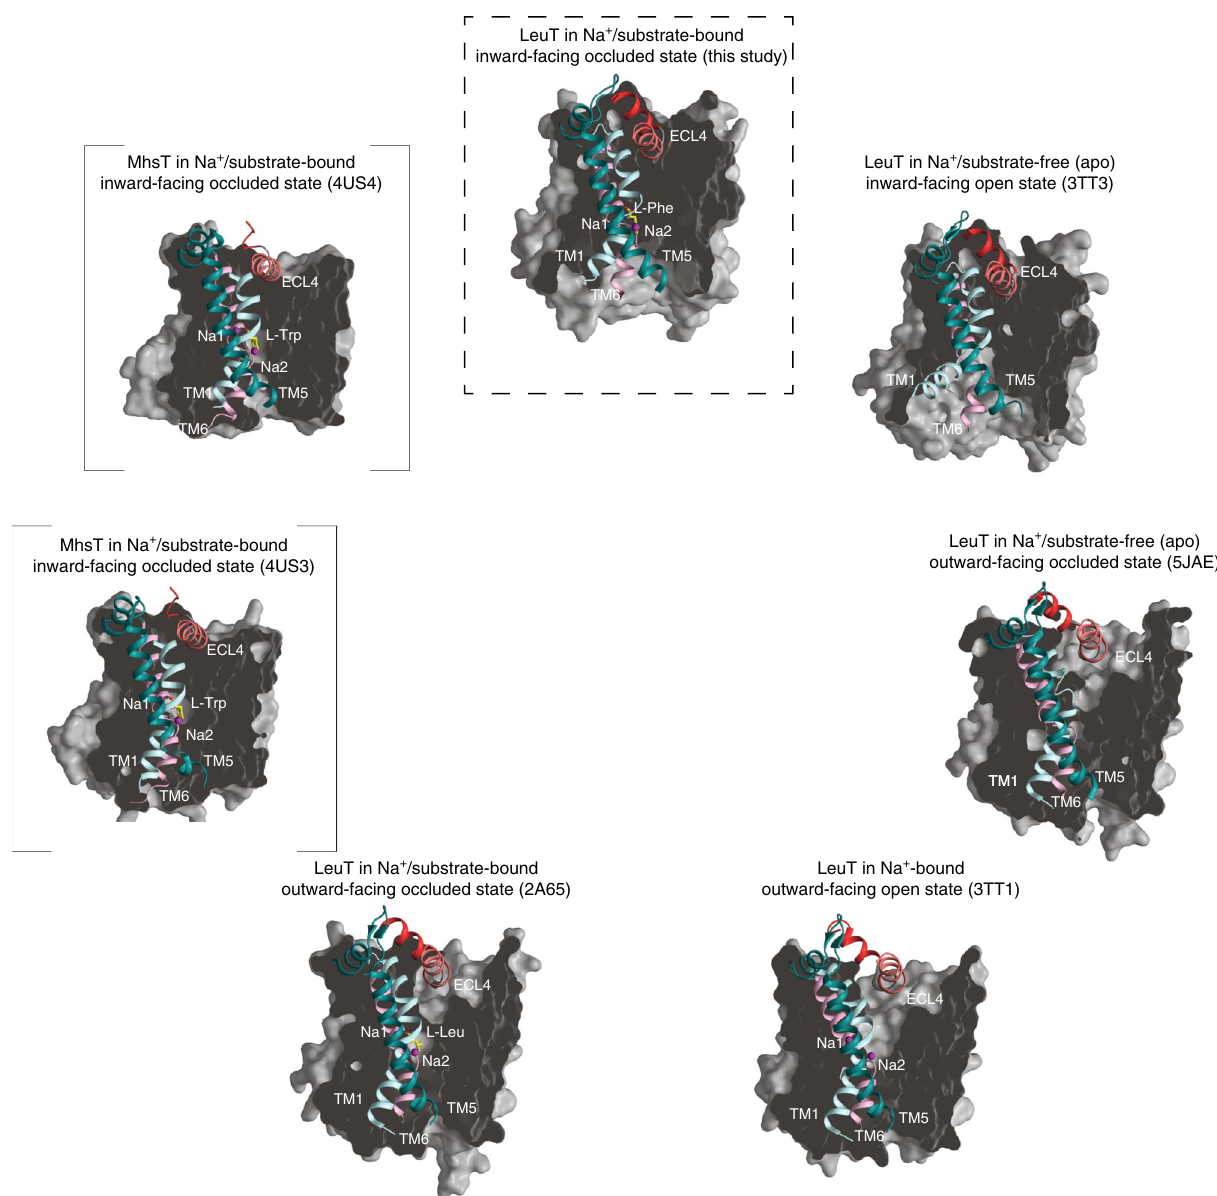
Fig. 7 Structures of LeuT and MhsT organized clockwise after progressive opening to the inside. The structures are shown as cross-sectional representations organized clockwise after progressive opening to the inside starting with the Na + /substrate free outward-facing occluded LeuT state (PDB-ID: 5JAE 12 ; middle right) followed by the Na + -bound outward-facing open LeuT state (PDB-ID: 3TT1 11 ; bottom right), the Na + / L -Leu-bound outward- facing occluded LeuT state (PDB-ID: 2A65 10 ; bottom left), the Na + / L -Trp-bound inward-facing occluded MhsT state with an unwound TM5 (PDB-IDs: 4US3 13 ; middle left and in square brackets), the Na + / L -Trp-bound inward-facing occluded MhsT state with helical TM5 (PDB-IDs: 4US4 13 ; upper left and in square brackets), the Na + / L -Phe-bound inward-facing occluded state of LeuT (this study; top middle) and the apo inward-facing open LeuT state (PDB-ID: 3TT3; top right). For clarity, only the orientation of transmembrane segments (TMs) 1, 5, and 6, and extracellular loop (ECL) 4 is shown to illustrate the most signi fi cant concerted movements related to opening and closure of the intracellular and extracellular vestibules, respectively. Sodium ions and substrate molecules are shown as purple spheres and yellow sticks, respectively. The structures support a model in which Na + /substrate reach the outward-facing binding sites via open extracellular vestibule, leading to its closure by the conformational rearrangements involving TM1, 5 and ECL4. The adapted inward-facing occluded conformation transits subsequently towards the inward-facing state, largely by the release of the N-terminal tail, disruption of the interactions provided by internal gate residues and changes in TM5 dynamics. Speci fi cally, the structures illustrate how changes in TM5 dynamics involving putative cytosolic unwinding followed by a progressive outward movement towards the membrane (from PDB-ID: 2A65 over PDB-ID: 4US3 and PDB-ID: 4US4 to the present structure of LeuT W8A ) putatively lead to formation of a large cytoplasmic cavity allowing access to Na2. Furthermore, as the transport cycle progresses, TM1 swings away from TM5 and 6 to open the intracellular vestibule that permits the release of bound Na + /substrate (PDB-ID: 3TT3). Finally, following Na + /substrate diffusion, TM1 and 5 pull back, and ECL4 uncaps the extracellular vestibule, facilitating the return to the apo outward-facing open state able to bind Na + /substrate